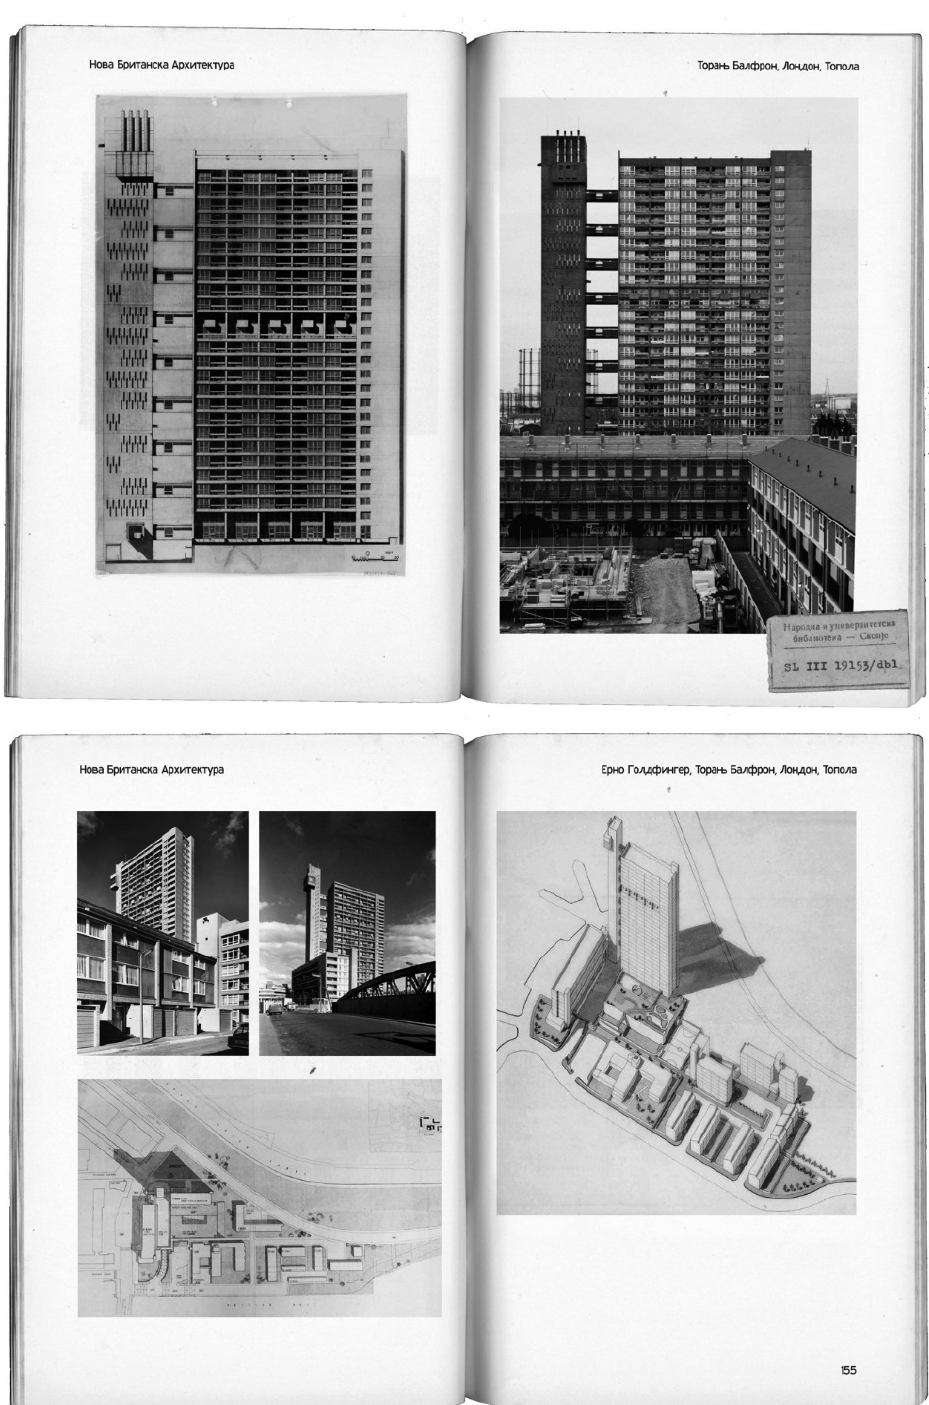
Figure 6. Georgi P. (1979), Nova Britanska Arhitektura , Architektonska Edizia,